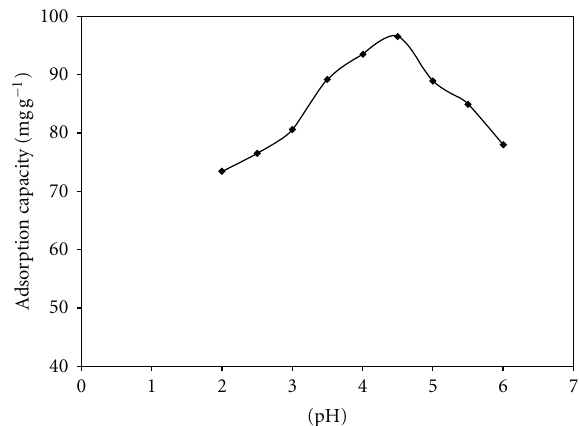
F 3: Effect of pH on the biosorption of Ni(II) onto T. viride biomass.